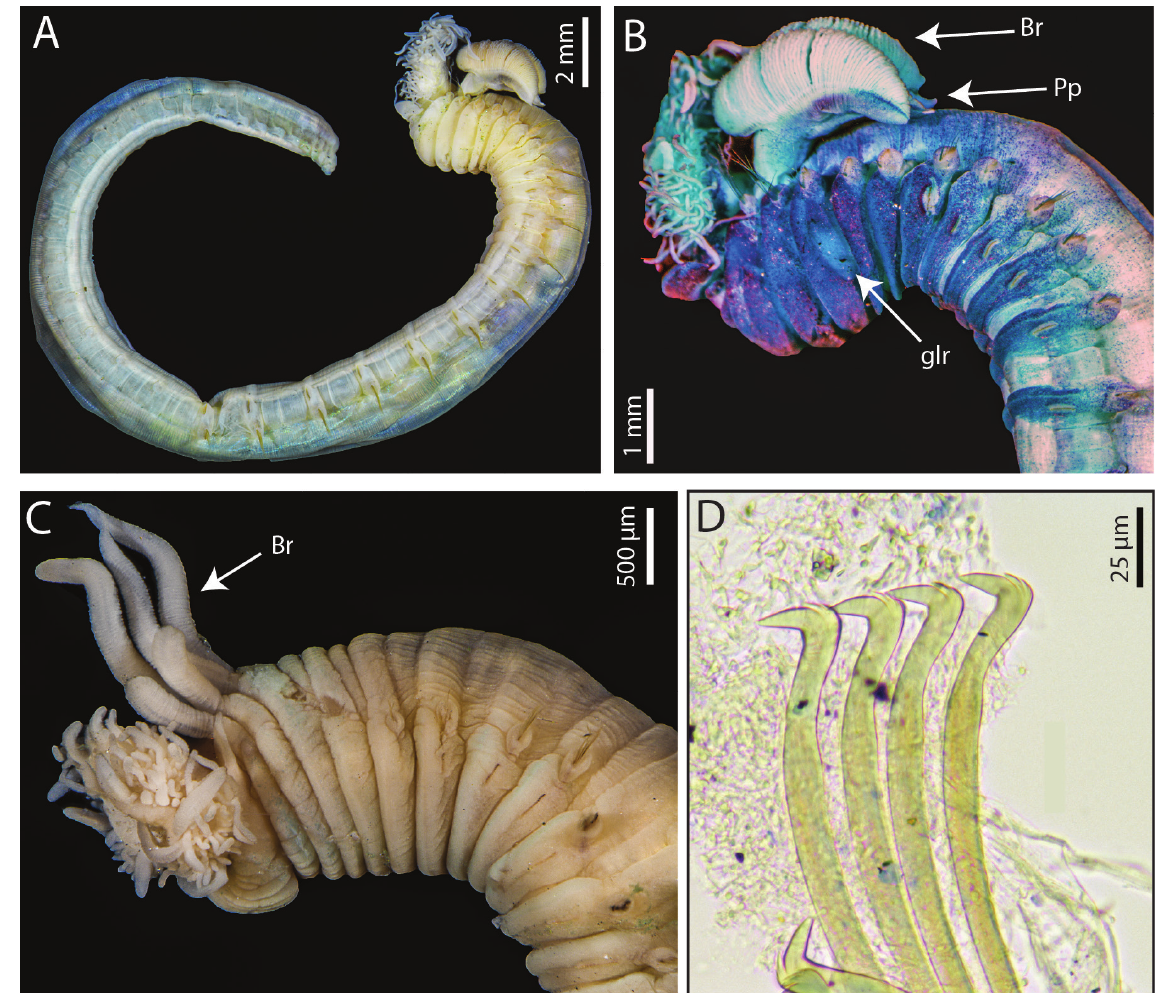
Fig. 7. Diversity of Trichobranchidae. A . Terebellides lilasae Lavesque, Hutchings, Daffe, Nygren & Londoño-Mesa, 2019, entire specimen, lateral view (MNHN-IA-TYPE 1879). B . Terebellides lilasae , anterior end, lateral view, methyl green staining (MNHN-IA-TYPE 1879). C . Trichobranchus glacialis Malmgren, 1866, anterior end, lateral view (MNHN-IA-PNT 96). D . Terebellides sp., thoracic acicular uncini (SMA-BR-Terebellides-KER1). Abbreviations: Br = Branchiae; glr = glandular region; Pp = Posterior